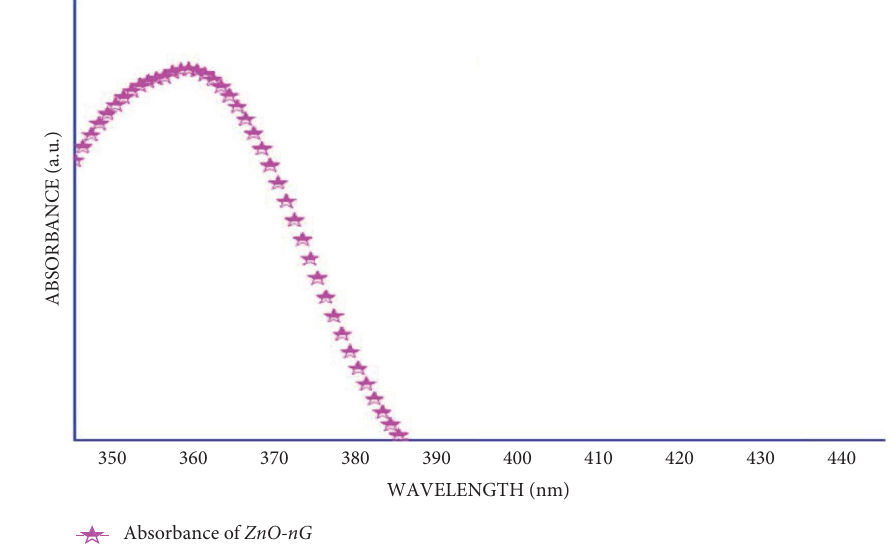
Figure 5: UV-vis spectra of G-ZnO NPs.